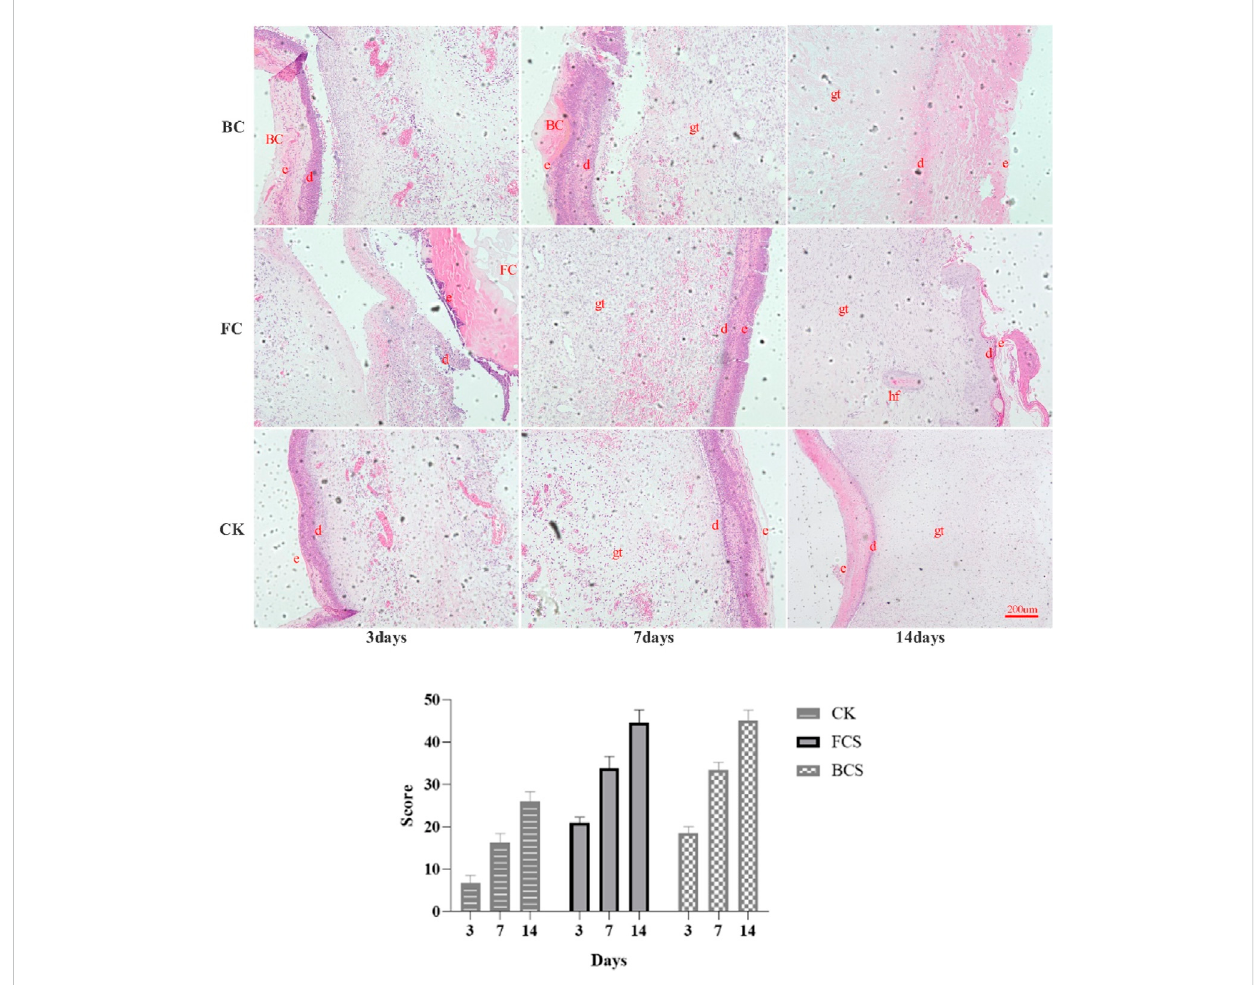
FIGURE 3 Analysis ofHEstainedwouldtissues(Magni fi cation,×100) andScores.(Thealphabeticletterse,d,gtandhfrepresentepidermis,dermis,granulation tissue, hair follicle, respectively. Scores in the histogram are the average scores of each time point calculated according to Table 4).